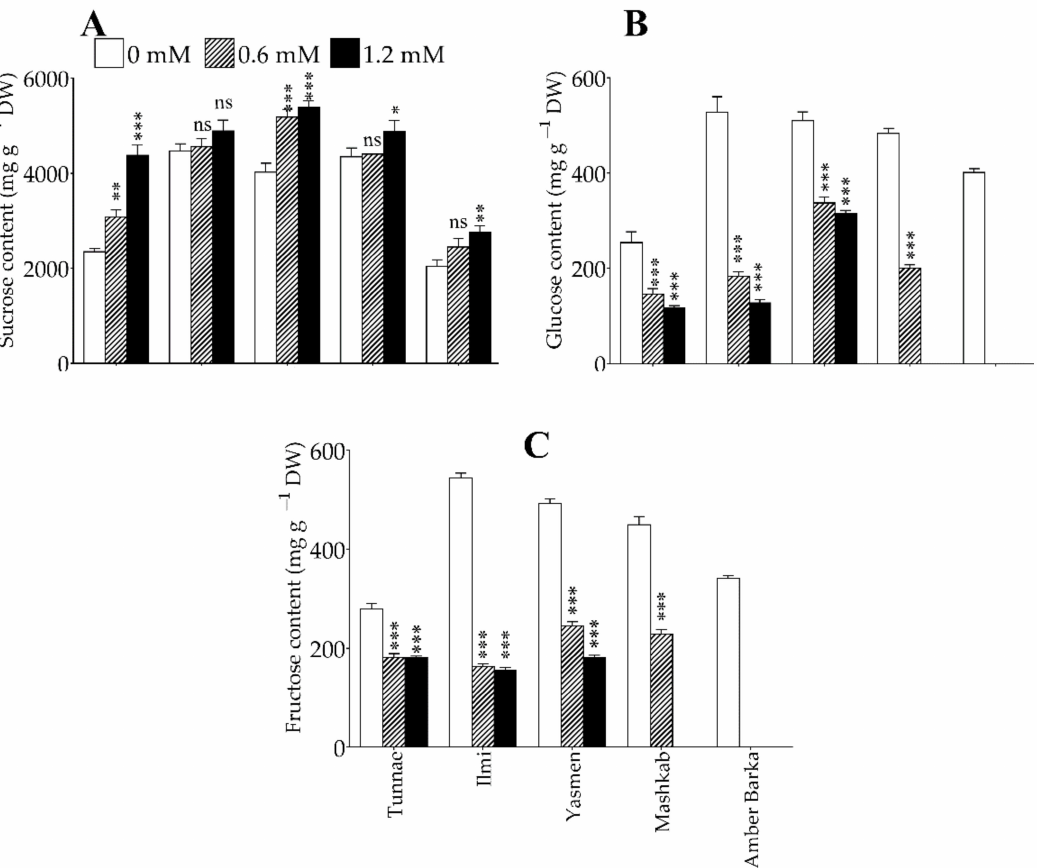
Figure 6. Changes in the soluble sugar content under lead treatment. ( A ) Sucrose content in five rice cultivars (Tunnae, Ilmi, Yasmen, Mashkab, and Amber Barka), ( B ) Glucose content and ( C ) fructose content in response to 0.6 and 1.2 mM lead (Pb) treatment. Bars are mean values ± SE. *** p < 0.001, ** p < 0.01, * p < 0.05, ns :